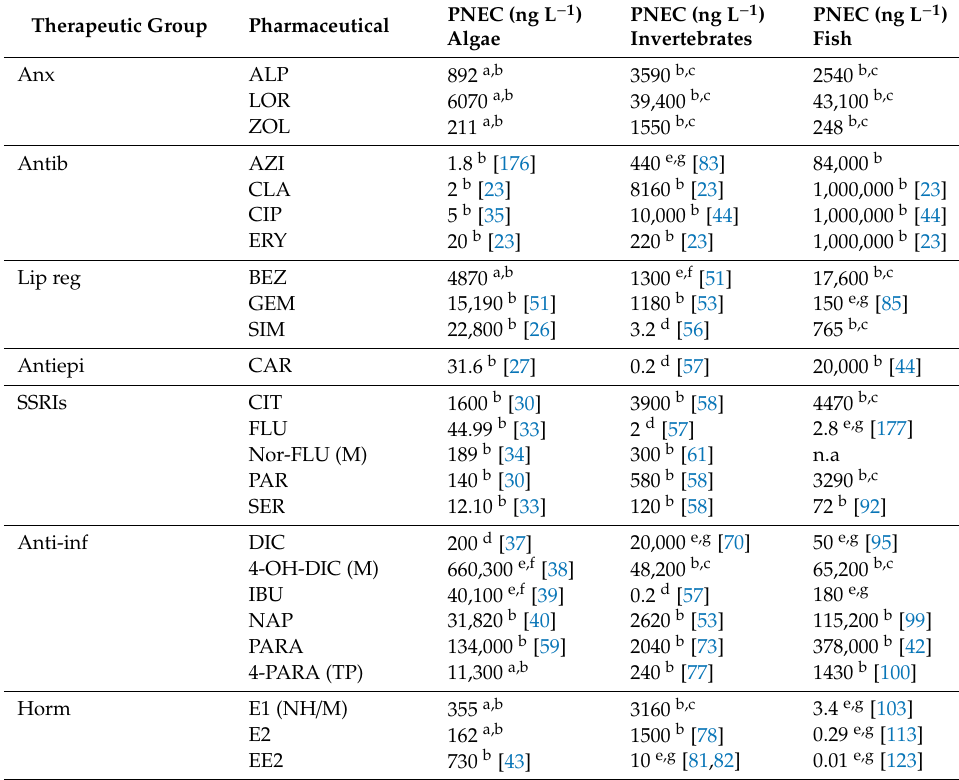
Table 2. Predicted no-e ff ect concentrations of the selected pharmaceuticals for algae, invertebrates and fish for the studied